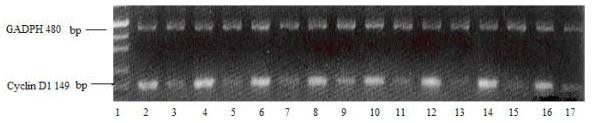
An ethidium bromide-stained 2% agarose gel for cyclinD1 gene amplification, lane 1: MW, lanes 2–8: cases of invasive squamous cell carcinoma, lanes 9–14: CIN cases, lanes 15–16: normal cervical tissue samples. Lanes 2,4,6,8,10,12,14 show cyclinD1 gene amplification.